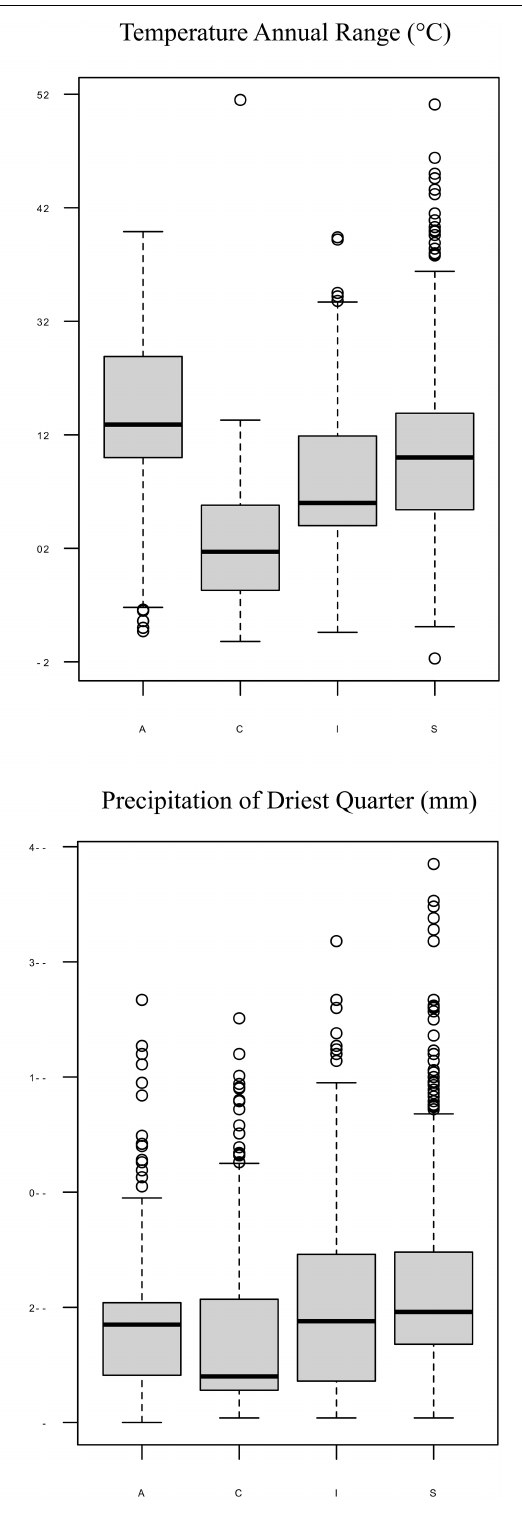
FIGURE 9 | Box-plot diagrams representing differences in climatic preferences for four clades of Trebouxia photobionts—A, C, I, and S. Climatic data were obtained from the Global Climate Data—WorldClim.